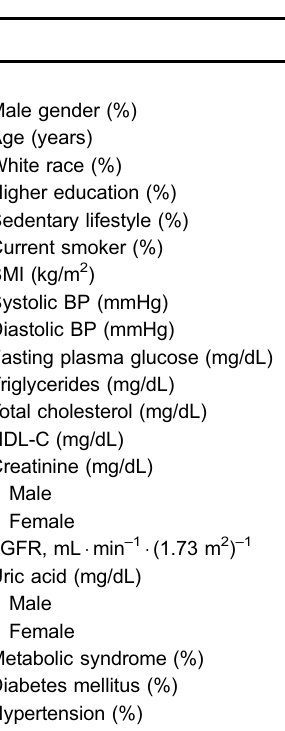
Table 1. Baseline characteristics of